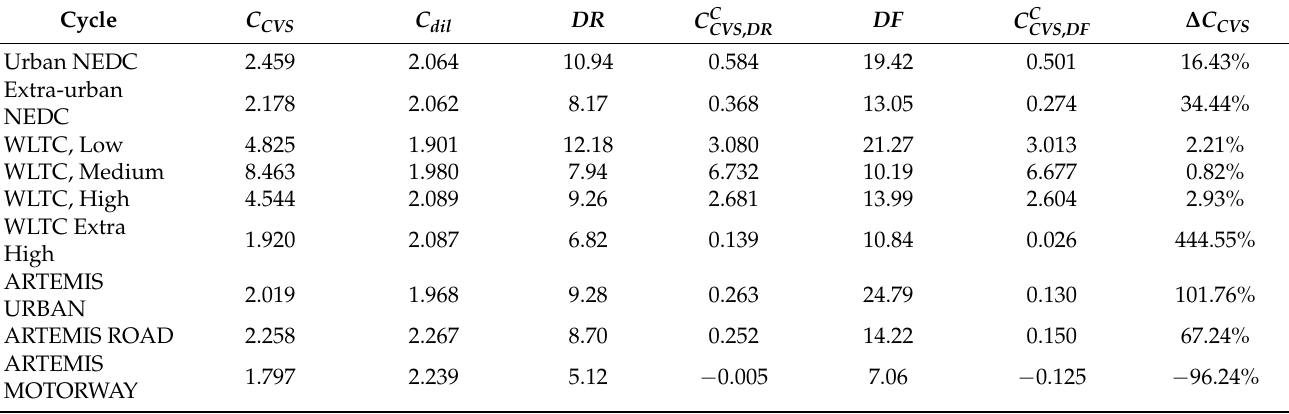
The C CVS,corr calculated based on Equations (5) and (21) for Euro 5 vehicle with CI engine, CH 4 concentration [ppm].